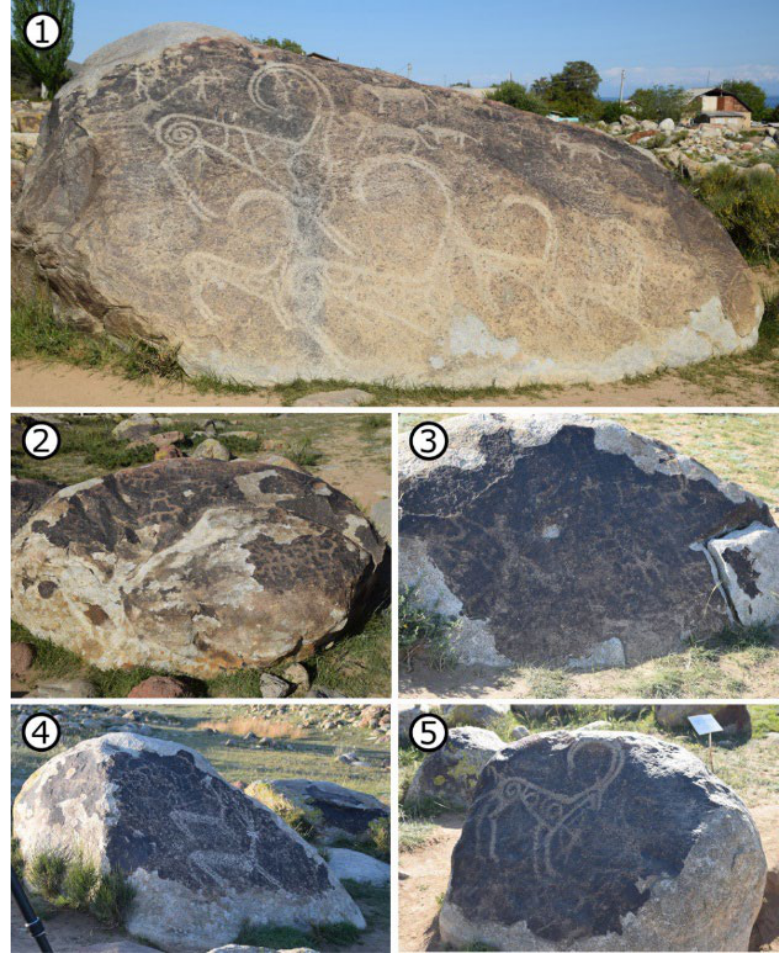
Figure 7. Petroglyphs selected for scanning. Presented numbers of petroglyphs are used in the following text. Source: authors’ own. Table 2. GPS scanner positions while obtaining petroglyph